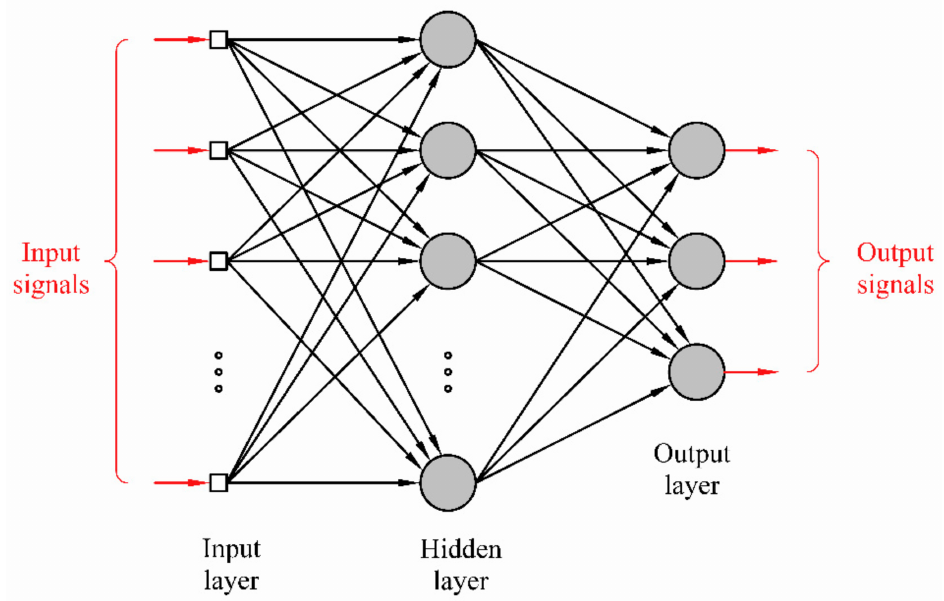
Figure 2. Fully connected multilayer perceptron with one hidden